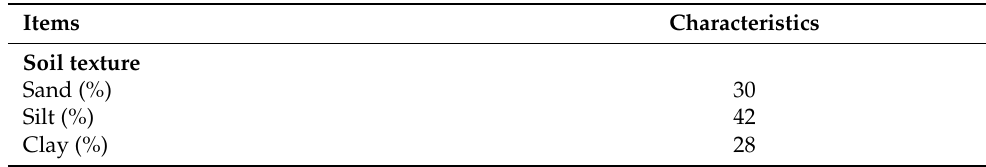
Table 2. Soil properties at the research site.